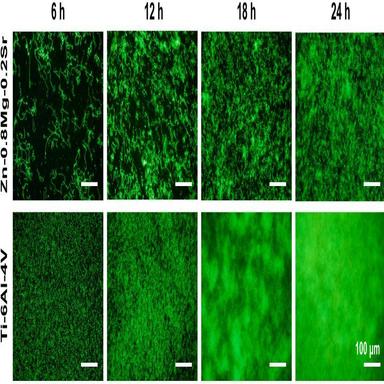
Initial bacterial adhesion and biofilm formation on the Zn-0.8Mg-0.2Sr and Ti-6Al-4V surfaces with S. gordonii after incubation of 6, 12, 18 and 24 h. Representative fluorescent images determined by a live/dead staining assay (scale bar = 100 μm).